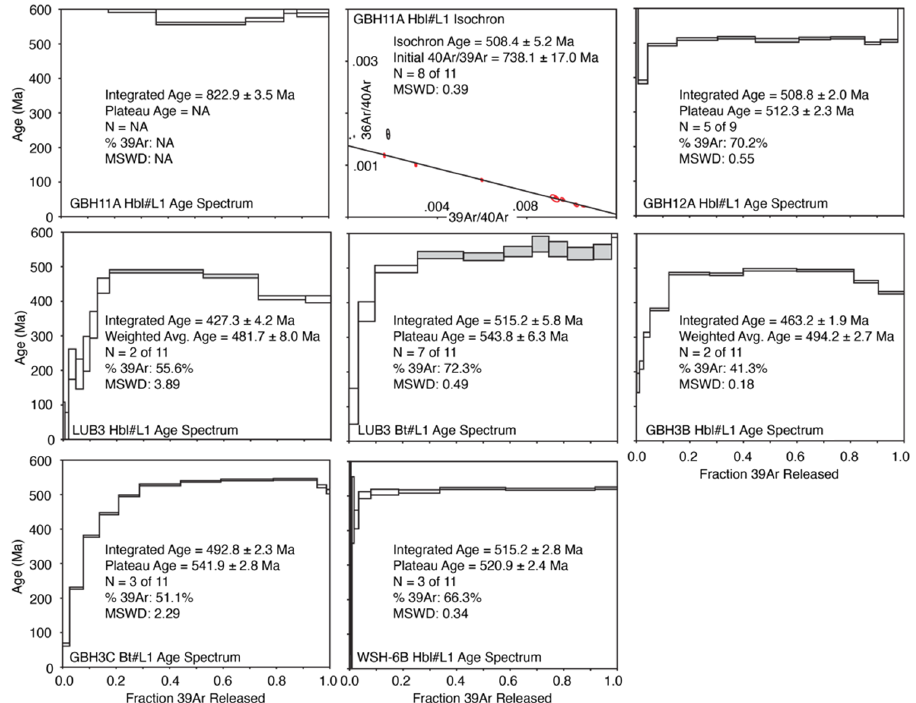
Figure 7. 40 Ar/ 39 Ar incremental release spectra for hornblende (Hbl) and biotite (Bt) mineral sepa- rates from unfoliated intrusive rock sample in the study area. Vertical axes represent age (Ma) and